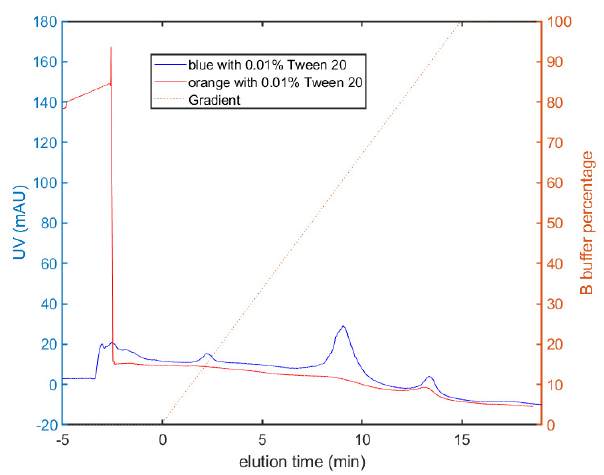
Figure 2. Membrane hydrophobic interaction chromatography for orange and blue nanoparticles.